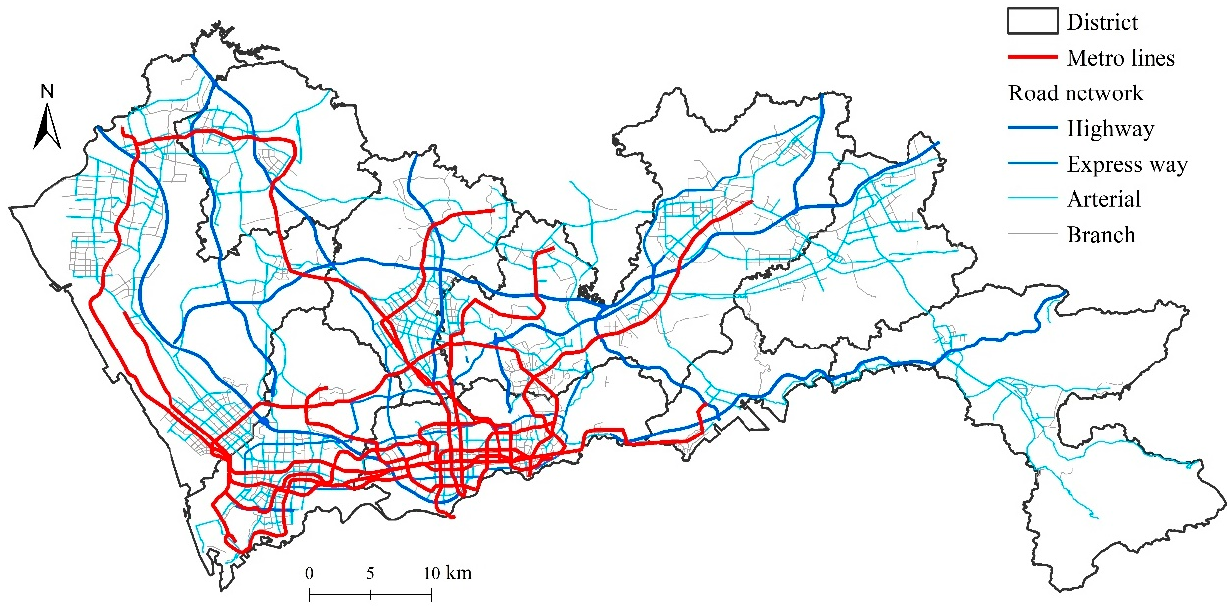
Figure 4. Metro and road networks in Shenzhen.